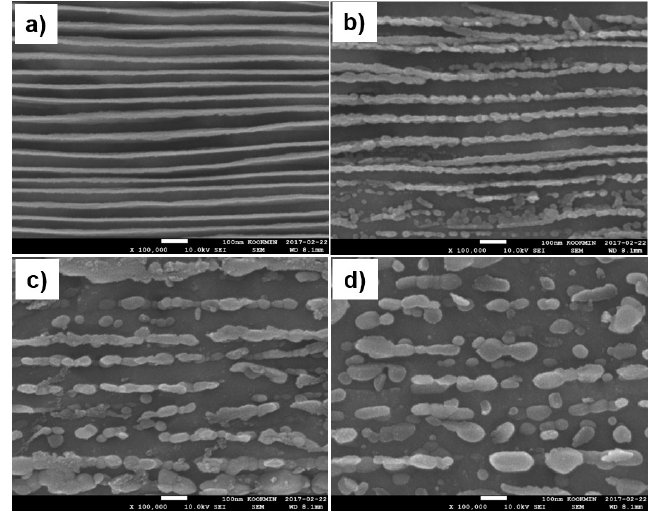
Figure 4. SEM micrographs, showing the microstructural evolution, ( a ) as drawn, and annealed at 500 °C for annealing time of ( b ) 30 s, ( c ) 15 min, and ( d ) 1 h. 500 ◦ C for annealing time of ( b ) 30 s, ( c ) 15 min, and ( d ) 1